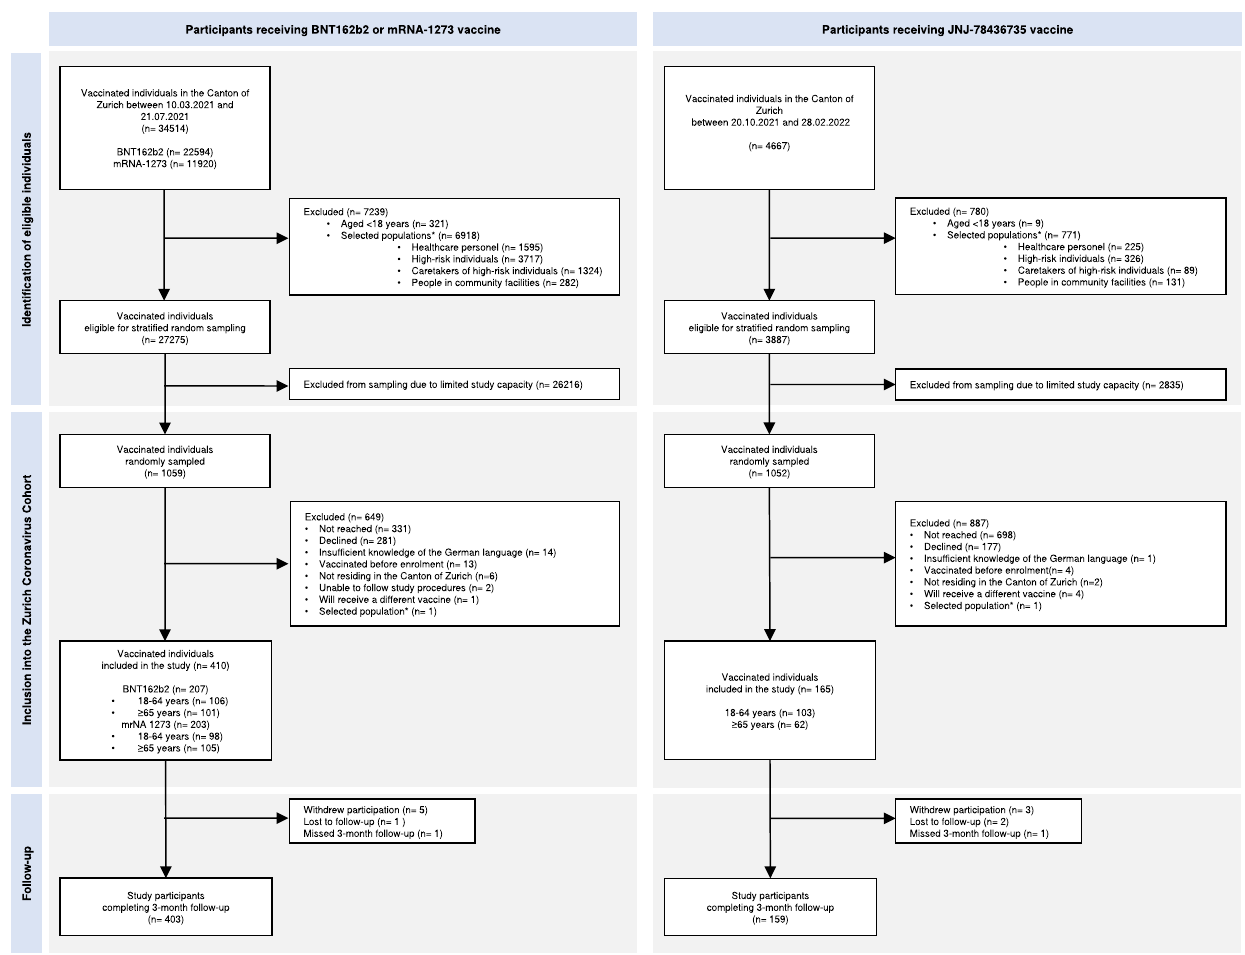
Fig. 4 Recruitment of study cohort (*as de fi ned by the Canton of Zurich ’ s vaccination guidelines 42,43 ). The left panel shows the recruitment fl owchart of participants receiving BNT162b2 or mRNA-1273 vaccine and the right panel shows the recruitment fl owchart of participants receiving JNJ-78436735